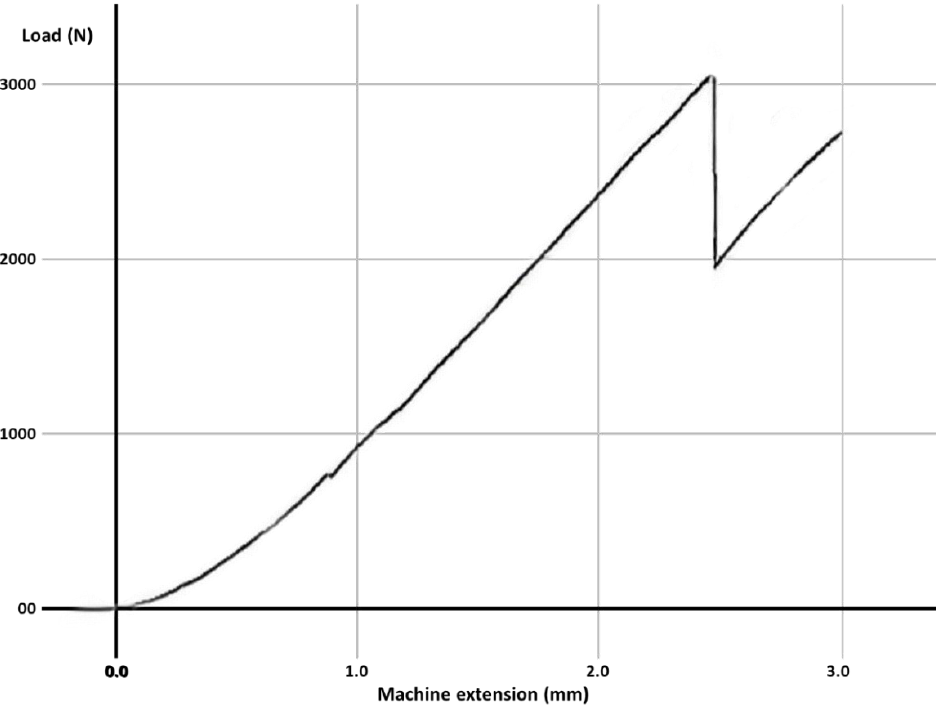
Figure 2. The maximum value of the force at which the most resistant molar from Group A failed.